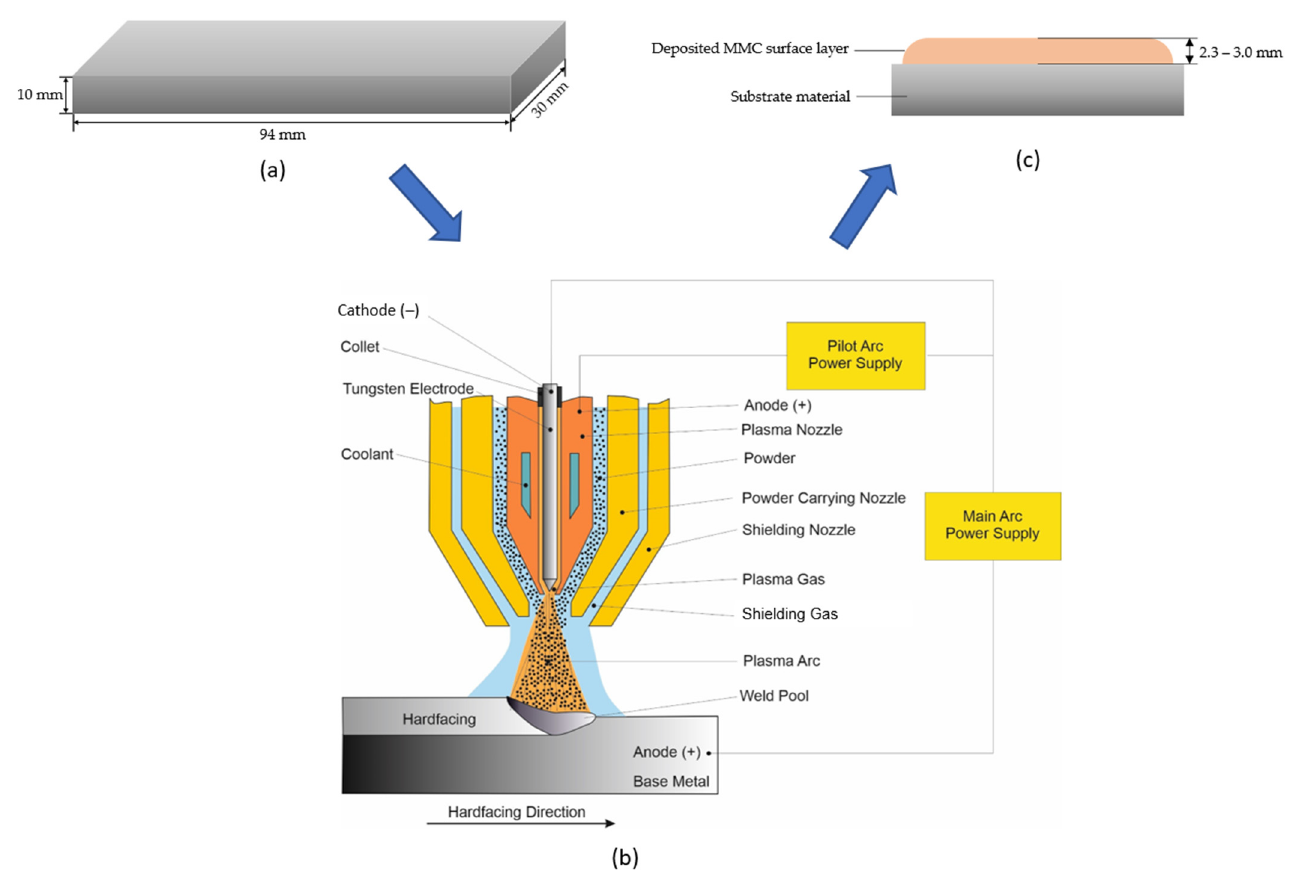
Figure 1. Process flow diagram for the surface cladding process ( a ) Image of the prepared structural steel plate specimen used for the study, including its dimensions ( b ) Schematic diagram of the PPTAW process ( c ) Schematic image of the cross-section of the final product after surface coating.